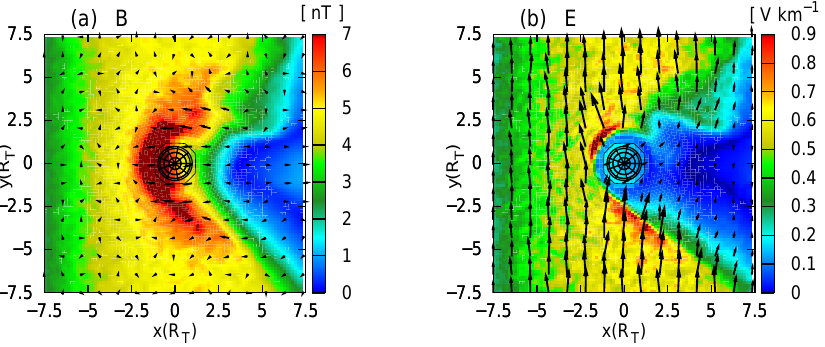
Fig. 7. Run #3 : Titan’s plasma environment when the moon is exposed to a periodic distortion according to eqs. (8) and (9). The period T = 2 π/ω of the distortion is T = 3500 δt , where 1333 δt correspond to the duration in which the magnetospheric plasma would pass through the simulation box one time. The plot shows another snapshot of the electromagnetic fields in Titan’s orbital plane. Compared to the preceding snapshot, the field direction is reversed. In the state displayed here, the region of increased field strength is located a little closer to the left-hand boundary of the simulation domain than in the preceding snapshot (compared to fig. 5, the light blue region near the left-hand boundary of the box is missing here).